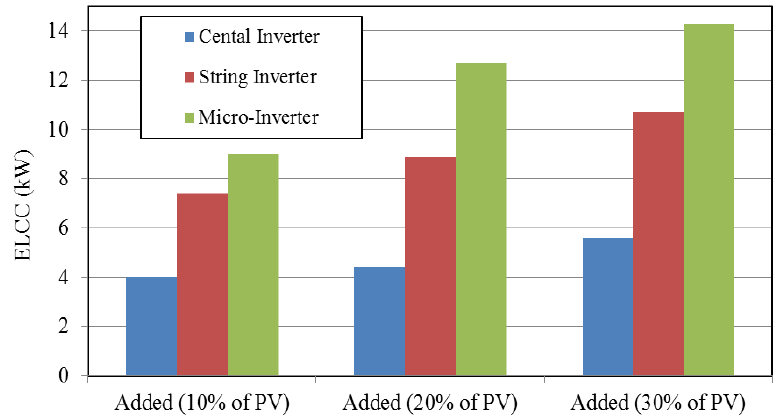
Figure 15. Effective load carrying capability for different PV topologies.